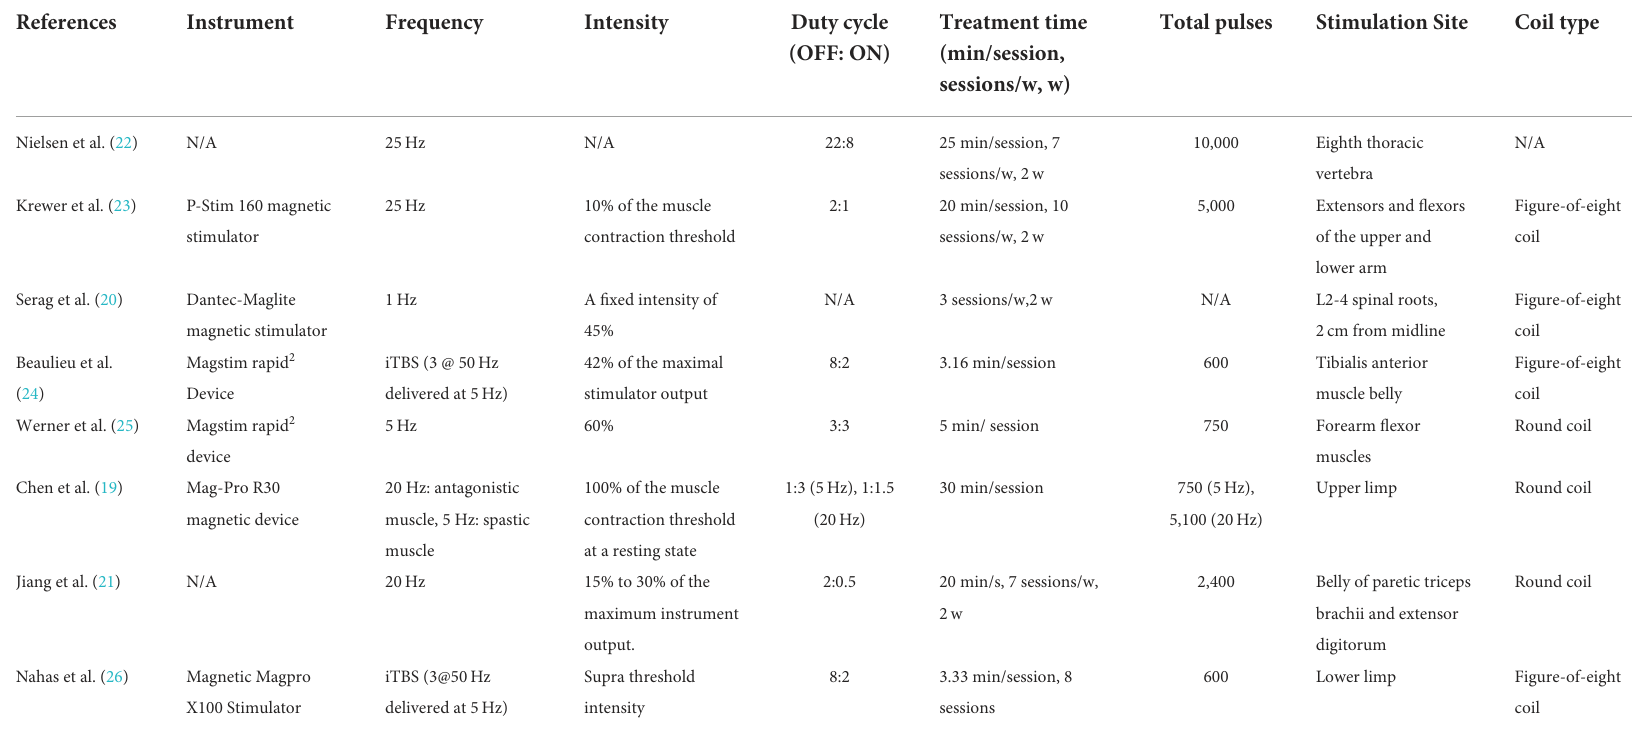
TABLE 2 Characteristics of rPMS